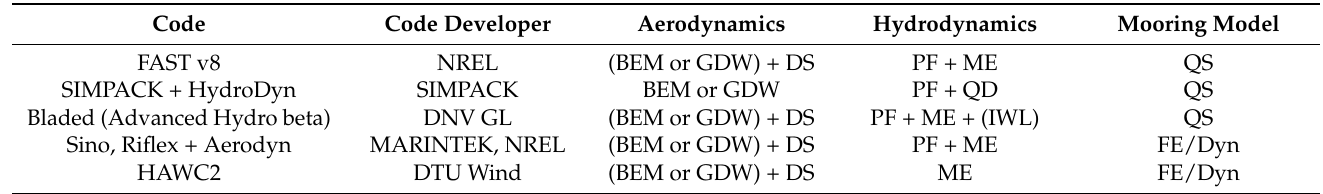
Table 1. List of codes for fully coupled aero-hydrodynamic analysis of floating offshore wind turbines. Code Code Developer